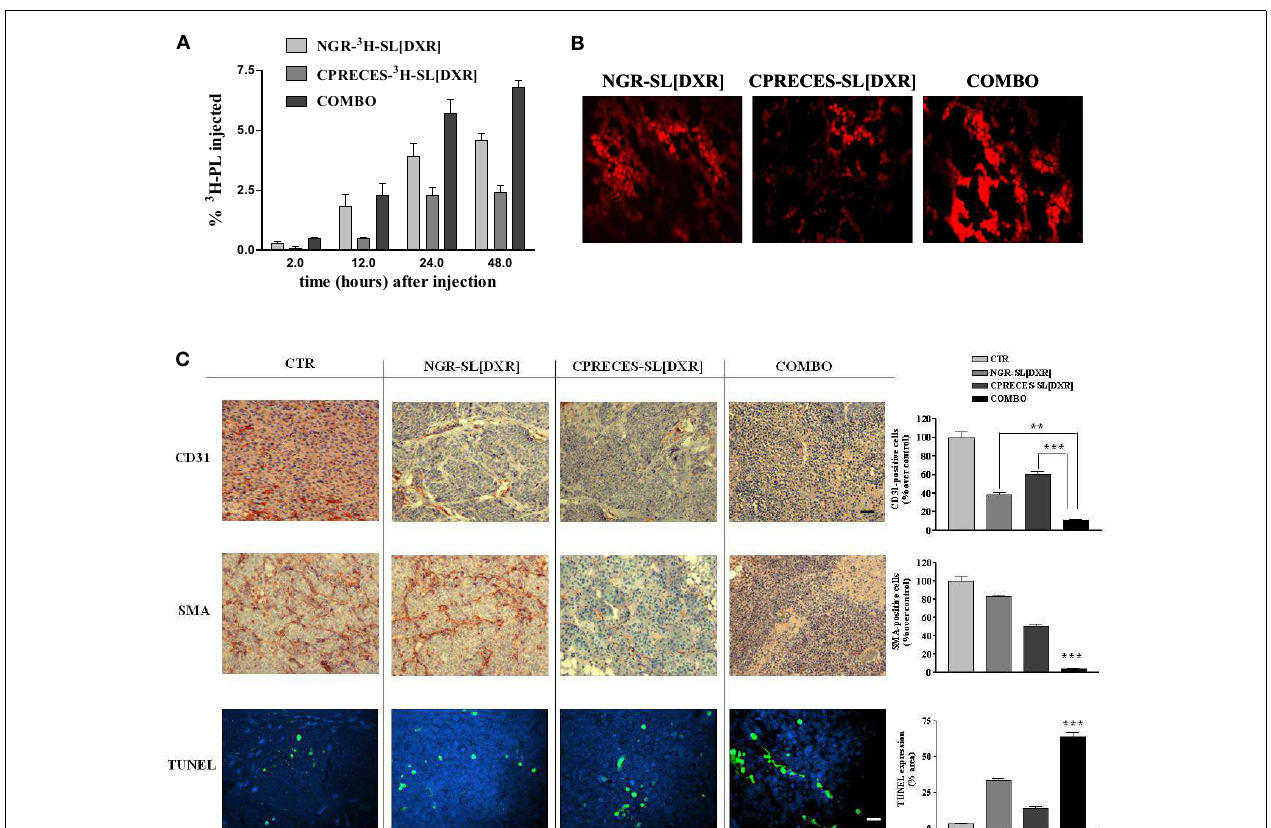
NB tissue sections. Magnitude, 40 × . (C) Effects of the combination therapy on endothelial, perivascular, and tumor cells in vivo . Immunohistochemistry was performed on established NB tumors removed from untreated mice (CTR) or from mice treated with DXR-loaded, NGR-targeted or CPRECES-targeted nanocarriers, or with a combination of the two liposomal formulations (COMBO).Tumors were removed on day 36 and tissue sections were immunostained for CD31 and SMA to detect tumor vasculature (scale bar, 250 µ m).TUNEL was performed to detect tumor apoptosis (scale bar, 100 µ m). Cell nuclei were stained with DAPI. Columns, mean of CD31, SMA, andTUNEL staining intensities; error bars represent 95% C.I. ** P < 0.01; *** P < 0.001, COMBO vs. single